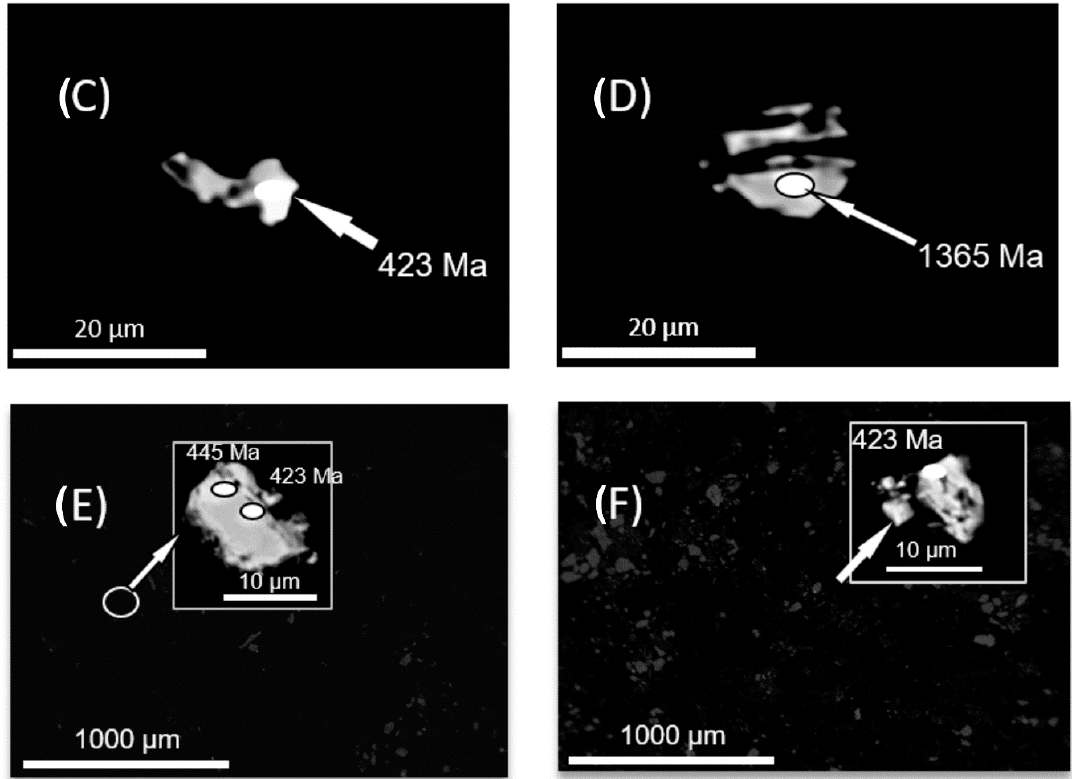
Figure 8. Dated monazite grains from Recherchebreen ( A – D ) and Storbreen (( E , F ), the position of the grain in the background SEM image is encircled). Five of six analyzed grains yielded Silurian ages, with one monazite grain of mid-Mesoproterozoic age. Scale bars are shown.